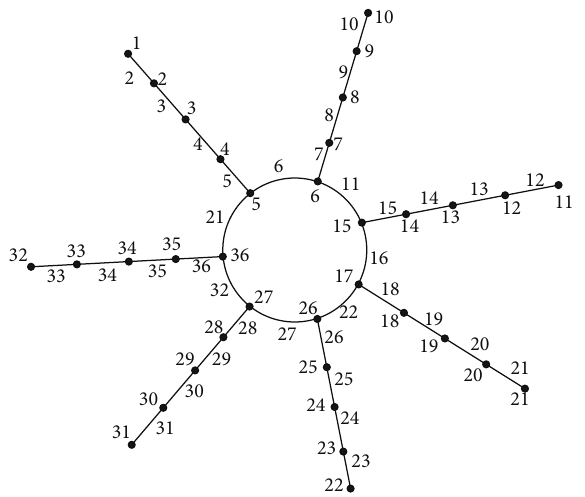
Figure 3: A C -exponential mean labeling of C P n